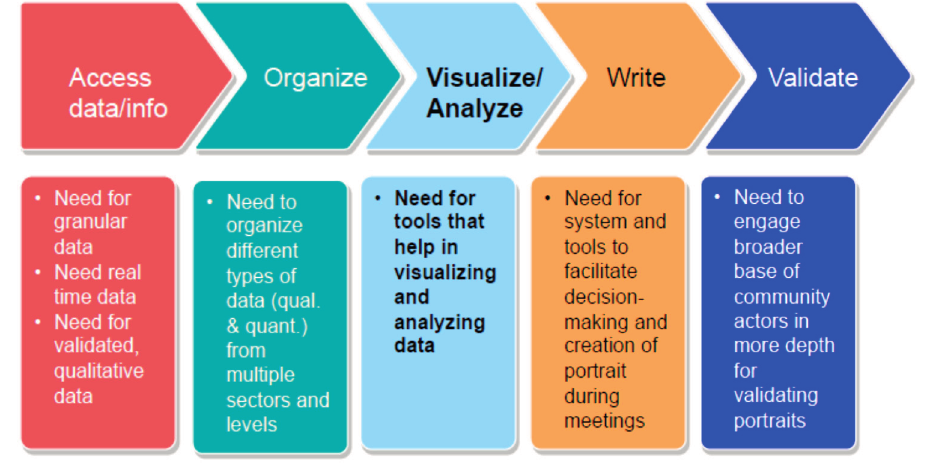
Figure 1. Community networks’ sub-processes for developing epidemiological profiles.